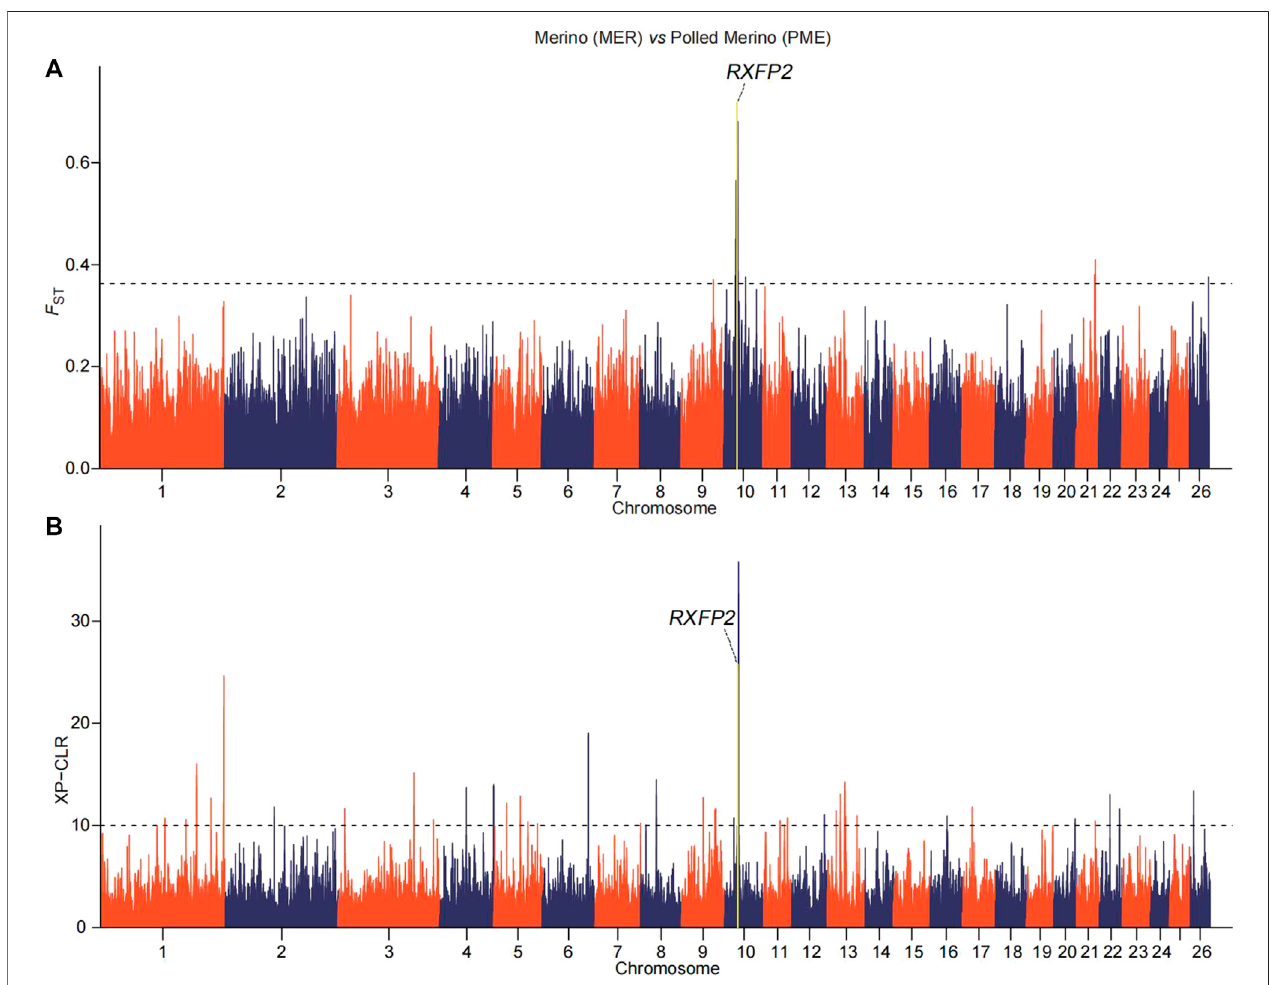
FIGURE3| Manhattanplotsof (A) pairwise F ST and (B) XP-CLRwithhornmorphologyinthecomparisonofPolledMerino(PME)andMerino(MER)breeds.Thetop 0.02% of the empirical distribution of F ST and 0.05% of the XP-CLR scores are indicated by dotted lines, respectively.